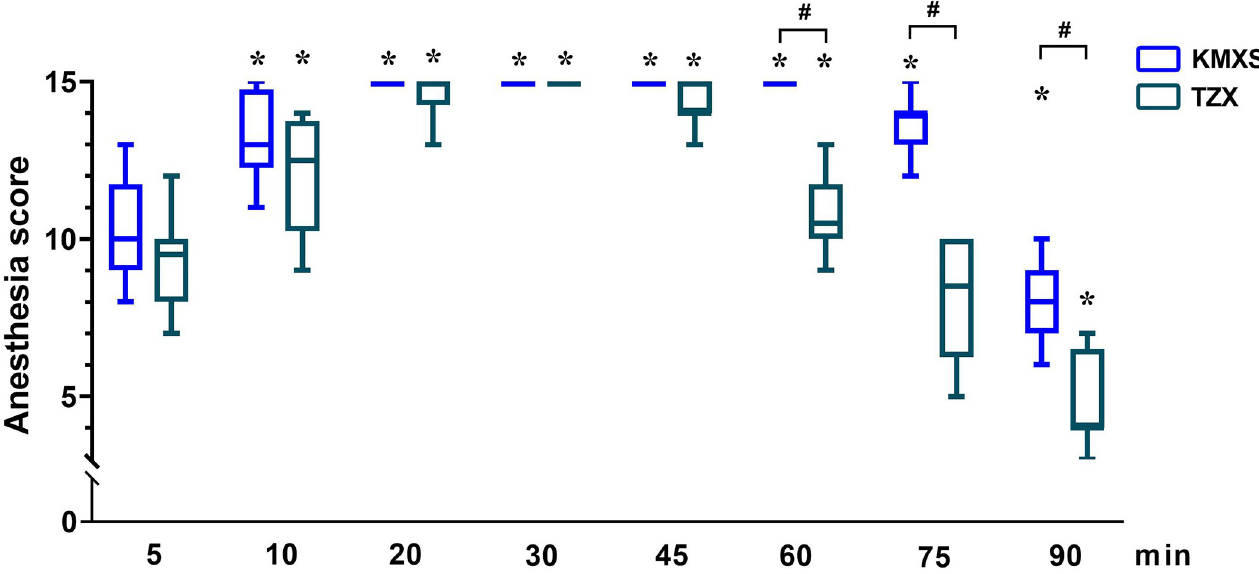
Fig 1. Anesthesia scores in pigs (n = 8) undergoing anesthesia with KMXS or TZX protocol at phase 1. KMXS protocol, 10 mg kg -1 ketamine, 0.5 mg kg -1 midazolam, and 2 mg kg -1 xylazine, plus 2 μ g kg -1 sufentanil. TZX protocol 4.4 mg kg -1 tiletamine-zolazepam plus 1.4 mg kg -1 xylazine. Values are expressed as medians (min-max). � Significantly different from baseline at the same group ( p < 0.05); # Significantly different between treatment groups ( p <